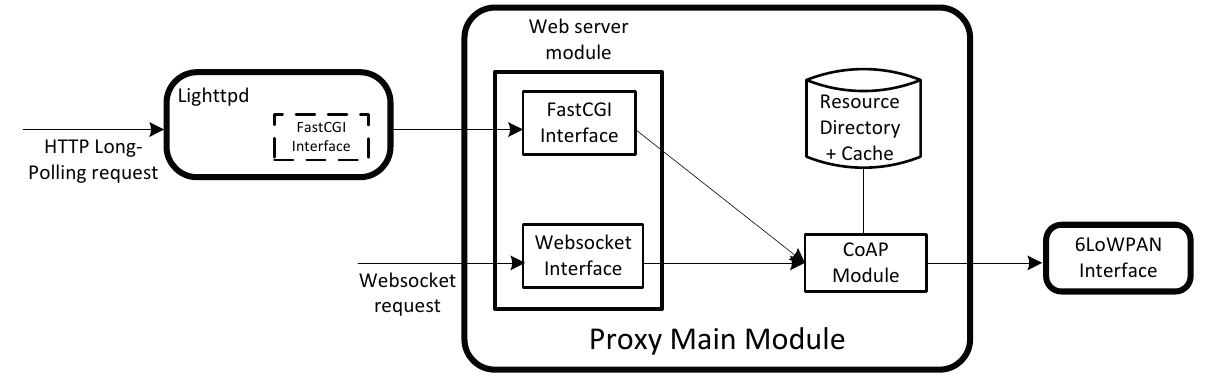
Figure 8. CoAP proxy design. The CoAP proxy is composed by three